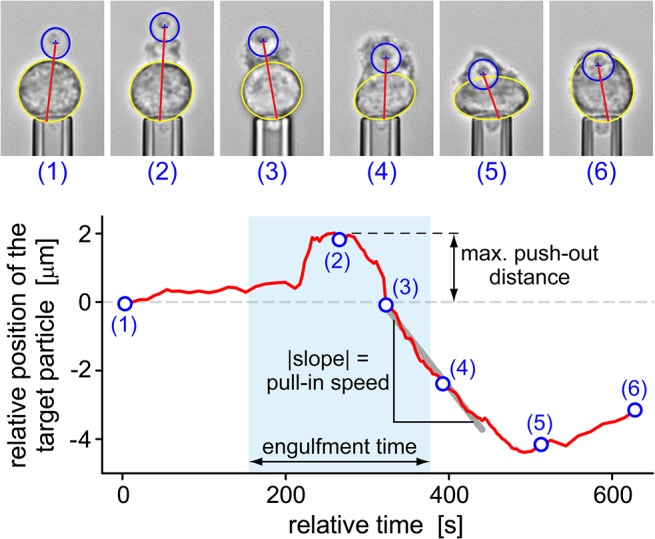
Analysis of the positional trajectory of a target particle (here: a C. posadasii endospore) during phagocytosis by a pipette-held neutrophil.The annotated videomicrographs at the top demonstrate our measurement of the distance between the center of the target particle and the opposite side of the main cell body (red straight line). This distance (relative to its initial value) is plotted as a function of time in the bottom graph (red curve). Numbered circles correspond to the time points at which the respective example images were taken. This type of graph allowed us to determine the maximum push-out distance as well as the pull-in speed of the target as shown. The engulfment time (defined in the text) was found by inspection of the recorded video images.